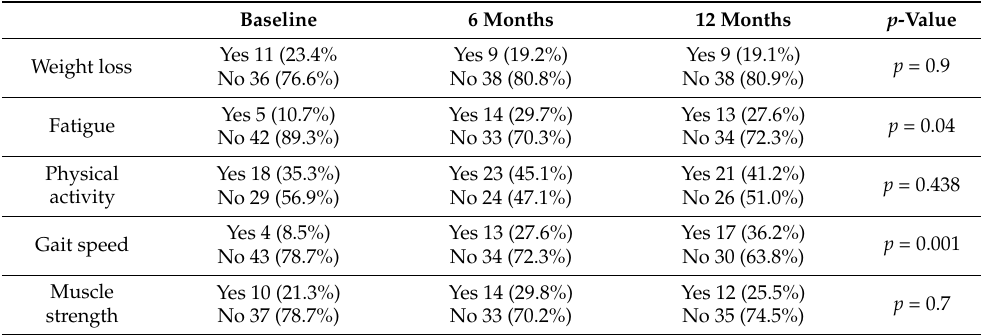
Table 2. Prevalence of frailty syndrome criteria at baseline and under AROi treatment.